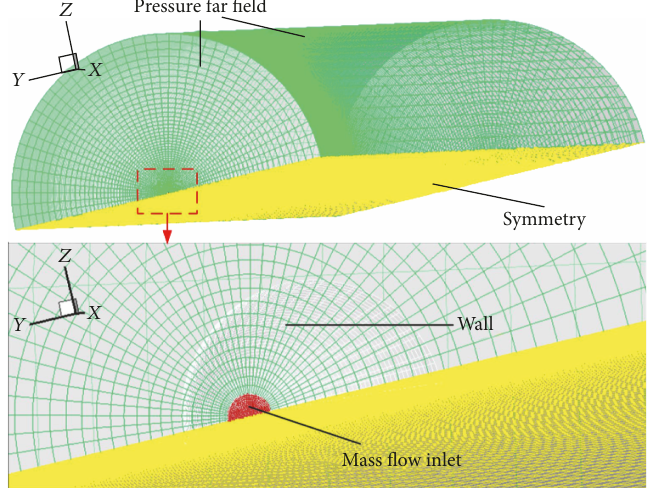
Figure 2: Mesh and boundaries of plume fl ow fi eld of single-nozzle